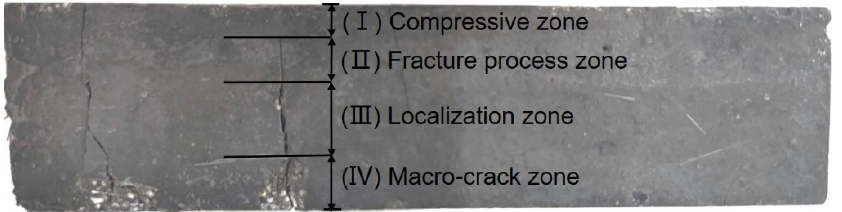
Figure 13. Straight BCSF-reinforced UHPC of 6 wt.% content cured for 28 days after bending test flexural strength test.